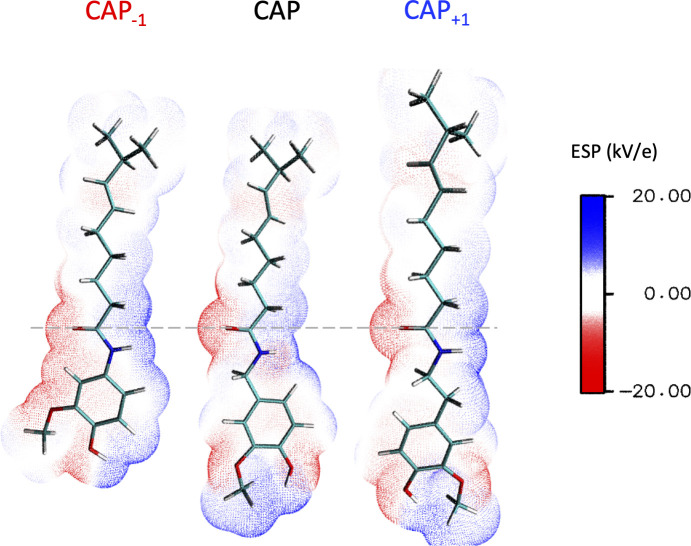
Electrostatic potential of capsaicin and its analogs.Dashed line marks the position of the carbonyl oxygen on the neck of the compounds. Scale bar represents the electrostatic potentials with blue being electropositive and red being electronegative.